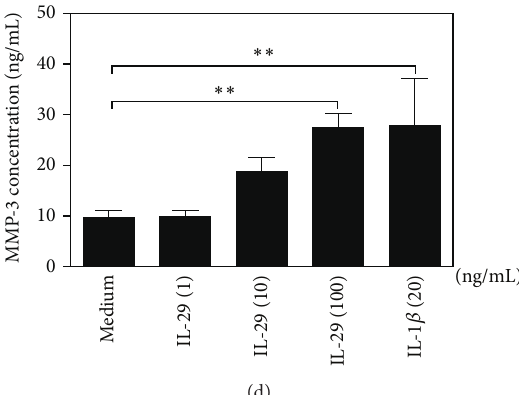
Figure 5: Effects of IL-29 on cartilage degradation by OA FLS ex vivo . (a) The OA cartilage depletion after being cocultured with OA FLS for 72 h was visualized in Safranin O/Fast Green-stained sections. Representative images from one experiment are reported (a), and the reduced intensity of red stain denotes proteoglycan loss (original magnification × 100). (b) The depth of GAG depletion ( 𝜇 m) in cartilage was measured from the articular surface to the red/orange tidemark (marked by arrow). (c) The ratio of MM-1, MM-2, MM-3, and MM-13 to TIMP-1 was determined by real-time PCR in OA FLS. (d) MMP-3 in culture supernatants harvested from each well after 72 h was measured by ELISA. The error bars represent mean ± SEM for triplicate experiments. ∗ 𝑃 < 0.05 versus medium control. ∗∗ 𝑃 < 0.01 versus medium